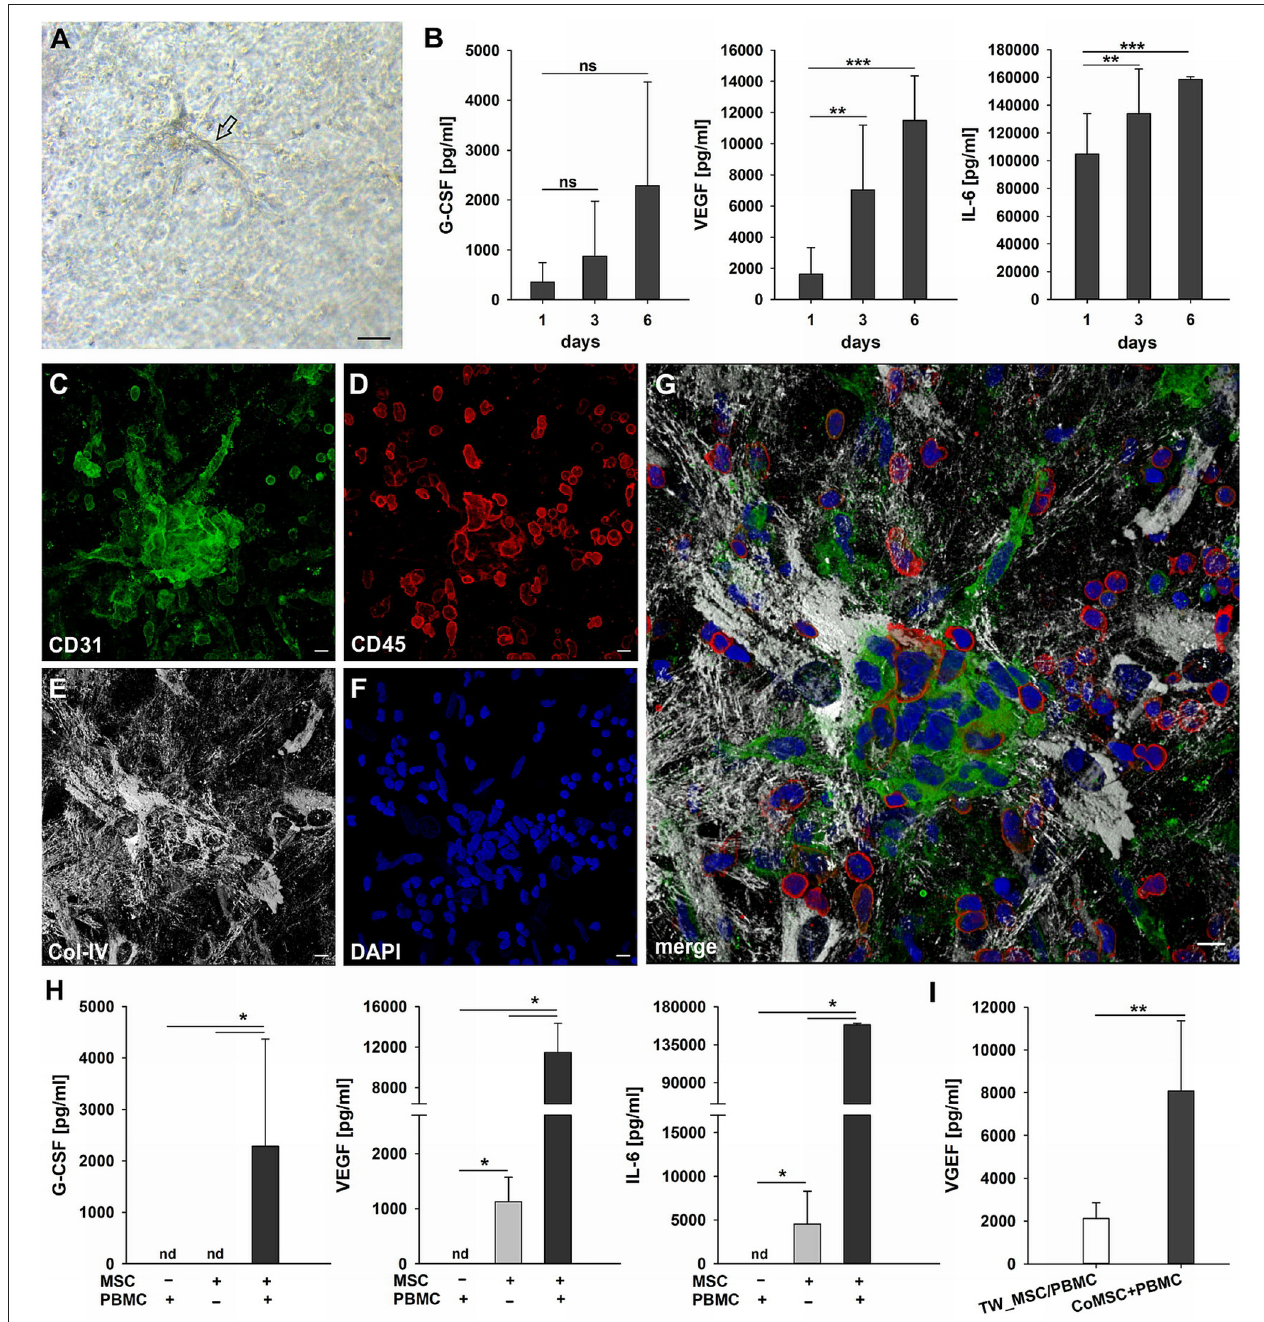
FIGURE 5 | Cluster formation, paracrine signaling and emergence of endothelial cells in 3D MSC-PBMC co-culture. (A) Phase contrast microscopy image of representative 3D fibrin co-culture of MSC with PBMC on day 6, demonstrating vascular sprouts (arrow). Scale bar, 50 µ m. (B) Determination of G-CSF, VEGF and IL-6 by ELISA in cell-free supernatants of 3D MSC-PBMC co-cultures ( n = 6) after 24h, on day 3 and on day 6, respectively. The data are expressed as mean values ± SD. ** p ≤ 0.01. *** p ≤ 0.001. ns not significant. (C–G) Representative CLSM images of MSC-PBMC co-culture in 3D fibrin matrix on day 6 showing organized structures consisting of (C) CD31 + cell clusters with (D) partial co-expression of CD45. Note the numerous CD45 + round leukocytes surrounding the cell cluster. CD31 + /CD45 − outgrowth cells with EC morphology emerge from the cluster. The cluster is embedded in a meshwork of (E) Col-IV positive stromal cells and matrix. (G) Merge. (F) DAPI stain. Collapsed 16 µ m z-stack consisting of 33 consecutive images. Scale bars, 10 µ m. (H) Determination of G-CSF, VEGF and IL-6 by ELISA in cell-free supernatants of 3D PBMC mono-cultures ( n = 4), MSC mono-cultures ( n = 4) and corresponding MSC-PBMC co-cultures on day 6. (I) VEGF levels in cell-free supernatants of 3D co-cultures where MSC were physically separated from PBMC by a transwell insert with 0.4 µ m pore size and corresponding 3D MSC-PBMC co-cultures on day 6 ( n = 6). The data are expressed as mean values ± SD. nd = not detected. * p ≤ 0.05. ** p ≤ 0.01.